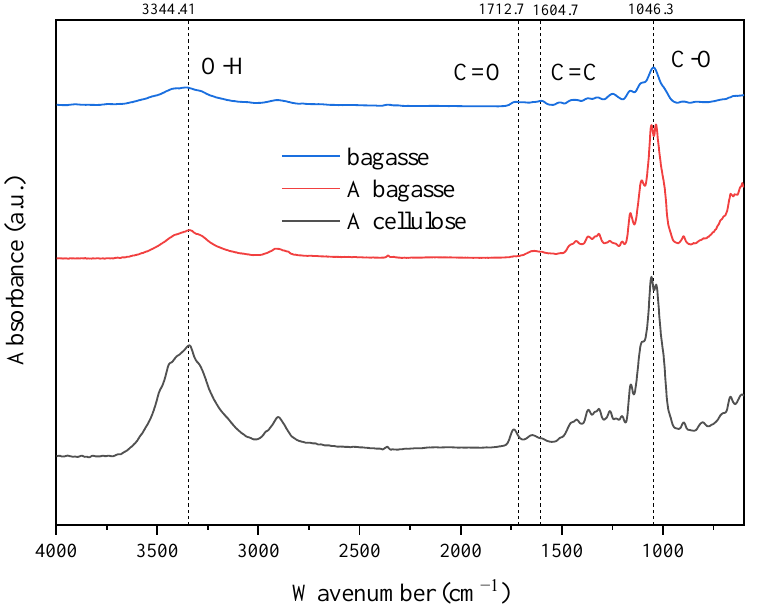
Figure 5. Infrared spectra of bagasse, bagasse after alkaline treatment (AB) and crude cellulose after L-DES treatment (AC).